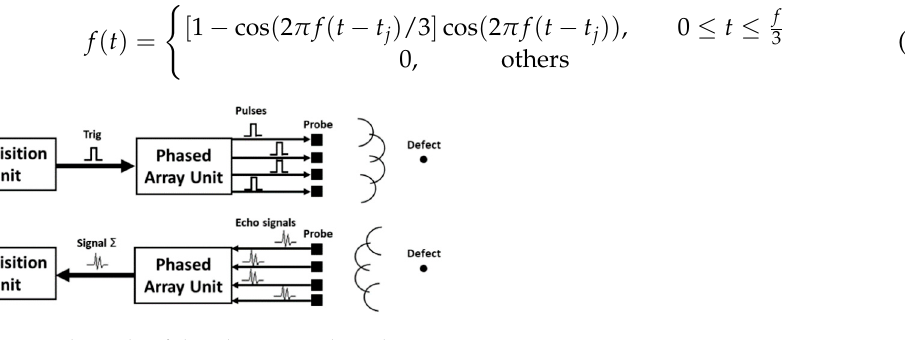
Figure 5. Delay rule of the ultrasonic phased array.